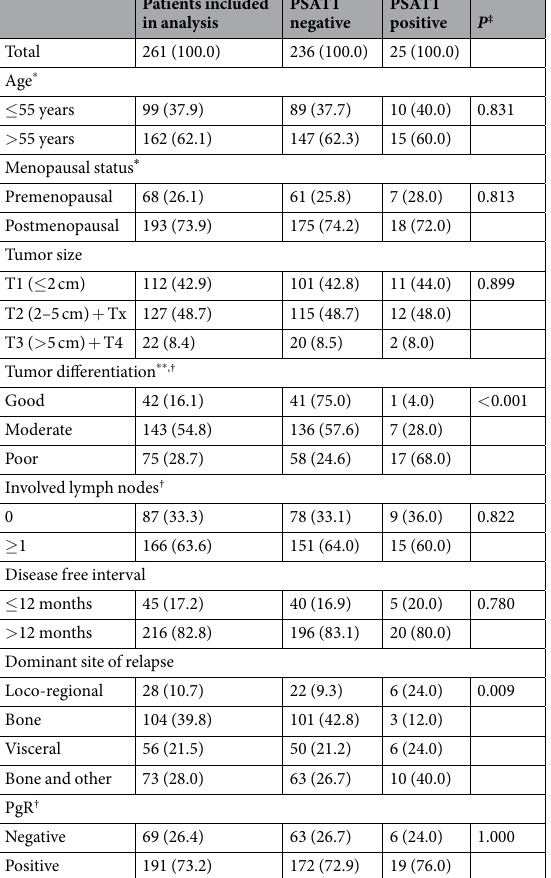
(Fig. S1A). Comparison between mRNA levels measured by Affymetrix platform and stratified according to IHC data (i.e. absent vs. present) did not show any significance (Mann-Whitney P = 0.133), probably due to imbalances in group distributions (i.e. PSAT1 positive = 3; PSAT1 negative = 28; Fig. S1B) and the small overlap between Affymetrix and TMA sets. PSAT1 mRNA levels measured by RT-qPCR and Affymetrix in 122 tumors showed moderate-strong correlation (Spearman r = 0.74; P < 0.001; Fig. S2). These data confirm that PSAT1 lev- els (mRNA and protein) show a similar trend when measured by either RT-qPCR or IHC. Clinical significance of PSAT1 in the gene expression cohort and pathway analysis. which genes were associated to PSAT1. First, we evaluated the expression of key breast cancer markers: ESR1 gene was found significantly downregulated in the poor outcome group after tamoxifen therapy (t test P = 0.009; fold change = 0.67). Key breast cancer prognostic markers, such as PGR (t test P = 0.168; fold change = 0.76) and ERBB2 (t test P = 0.123; fold change = 1.23), showed no change between the two patient categories. When assess- ing PSAT1 levels, a significant enrichment was found in the poor outcome patient group (t test P = 0.014; fold change = 1.37; Fig. 2C). In order to confirm that PSAT1 expression was associated to shorter TTP, we stratified patients in PSAT1 low and high expressing groups (cutoff: median expression; median Log2 intensity = 7.086) and performed survival analysis. Kaplan-Meier curves showed that patients whose tumors expressed high levels of PSAT1 suffered from faster tumor progression when compared to the PSAT1 low group (HR = 1.68; 95% CI: 1.20 to 2.36; Log-rank P = 0.003; Fig. 2D). The set was stratified based on median PSAT1 levels (categories: